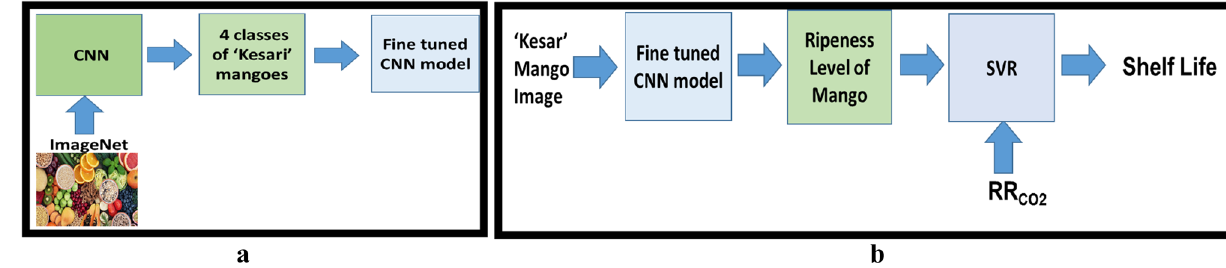
Fig. 2 Computational architecture for a fine-tuning of CNN, b prediction of shelf